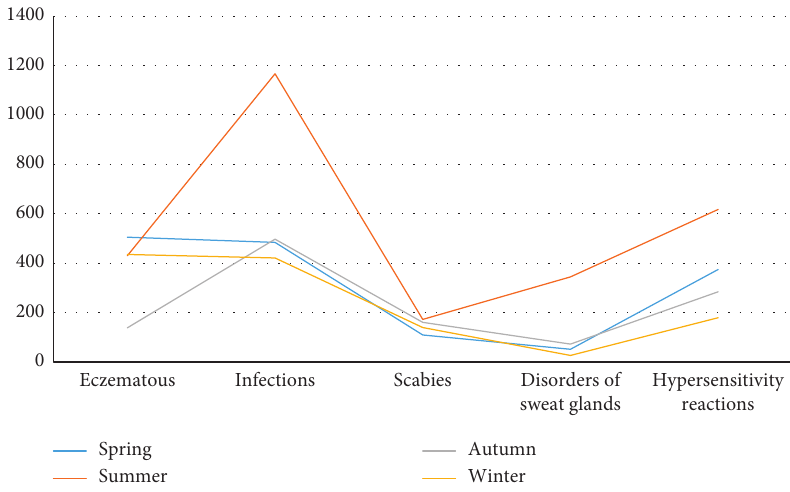
Figure 2: Distribution of common skin diseases according to the